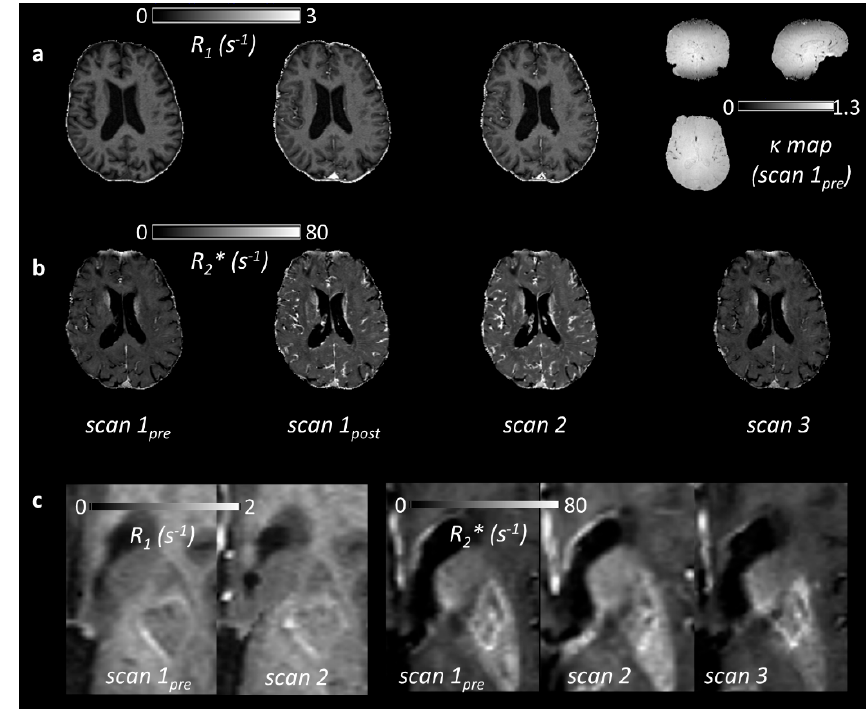
Figure 2. ( a ) R 1 maps for a single patient at three time points: pre-ultrasmall superparamagnetic particles of iron oxide (USPIO) (scan 1 pre ), immediately post-USPIO (scan 1 post ), and at 24–30 h post-USPIO (scan 2). The corresponding relative flip angle (i.e., k : the actual flip angle divided by the nominal value) map measured at baseline is shown on the right, illustrating both variation due to B 1 inhomogeneity and the (axial) slab excitation profile; ( b ) R 2 * maps in the same patient, obtained at the same time points and at 1 month post-USPIO (scan 3); ( c ) Parametric maps in another patient (79 year old male, first visit 31 days post-infarct in the left basal ganglia). R 1 is seen to increase visibly in the stroke lesion following USPIO administration. The corresponding change to R 2 * is more subtle in the stroke lesion, but a visible increase is seen in the neighbouring background tissue.